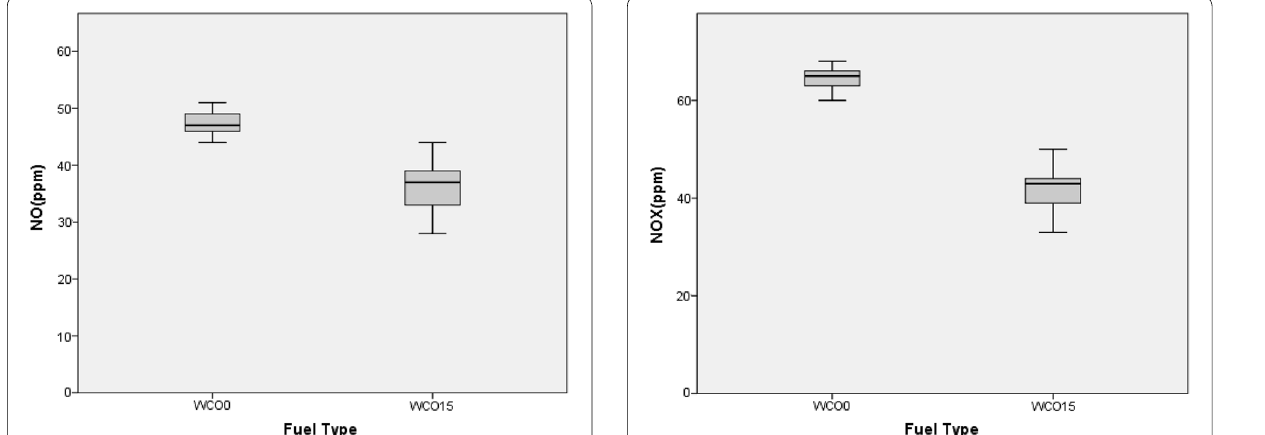
Fig. 5 Box plot diagrams of driving and exhaust characteristics [NO emission (Unit: ppm)]